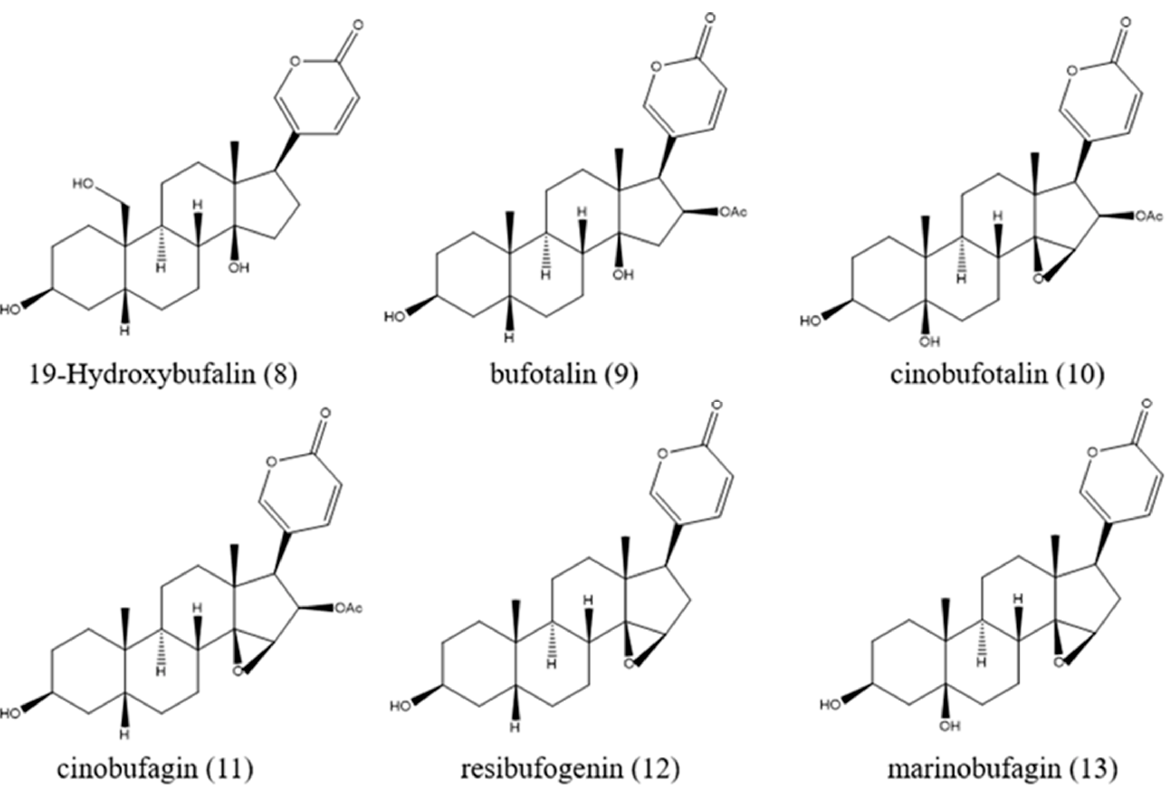
Figure 2. Chemical structure of the main bufadienolides.